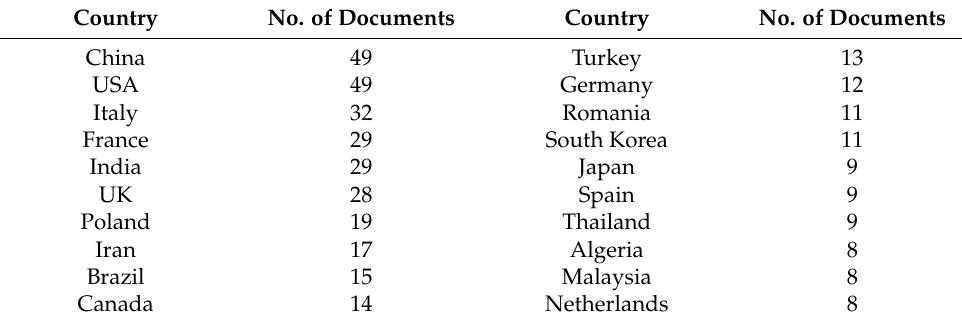
Table 3. Top 20—Most productive countries in the research area